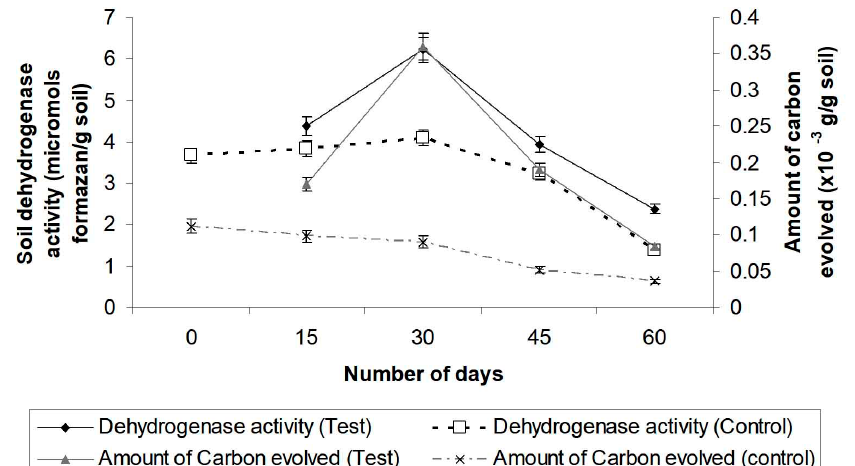
Fig. 5. Measurement of microbial activities in biofertilizer inoculated pots of Abelmoschus esculentus , compared to control pots by soil dehydrogenase assay and CO